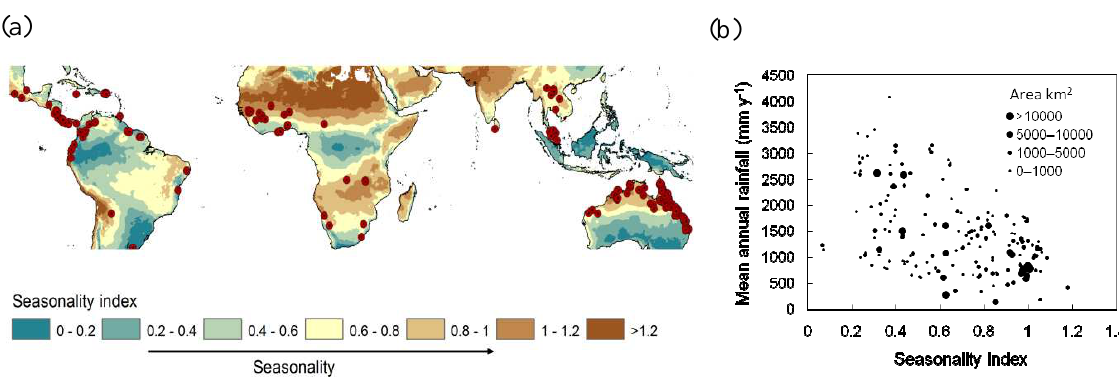
Fig. 2. Distribution of catchments in the dataset: (a) Geographic distribution (b) In terms of climate using the seasonality index (SI; Walsh and Lowler, 1981). Symbol sizes in (b) indicate catchment areas in km 2 .